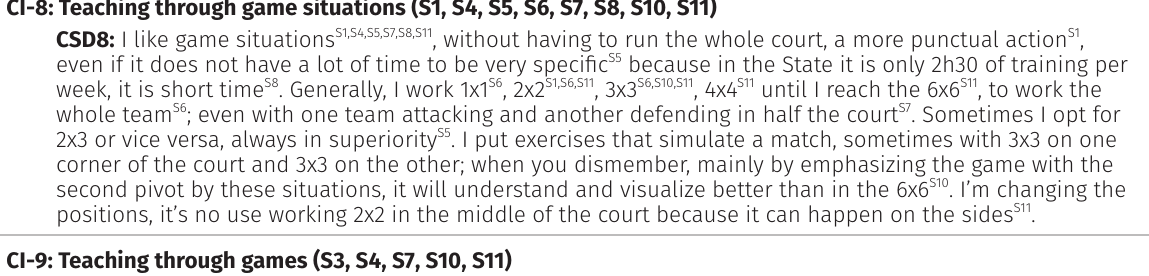
Table V. CSD on the teaching of collective defensive contents in the U-14 and U-17 teams. CI-8: Teaching through game situations (S1, S4, S5, S6, S7, S8, S10, S11) CSD8: I like game situations S1,S4,S5,S7,S8,S11 , without having to run the whole court, a more punctual action S1